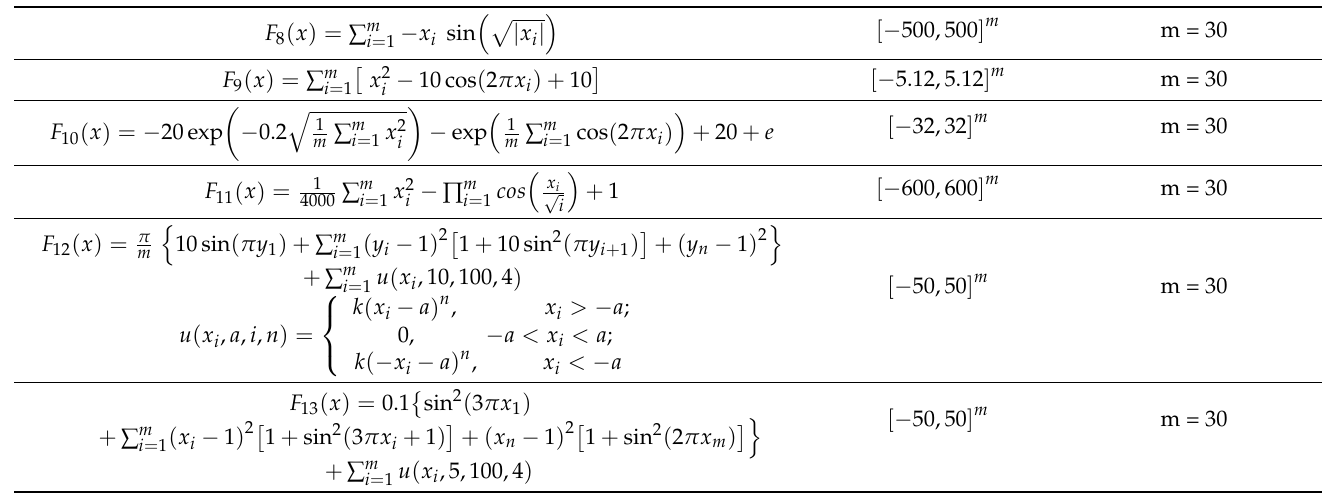
Table A2. High-dimensional multimodal test functions.